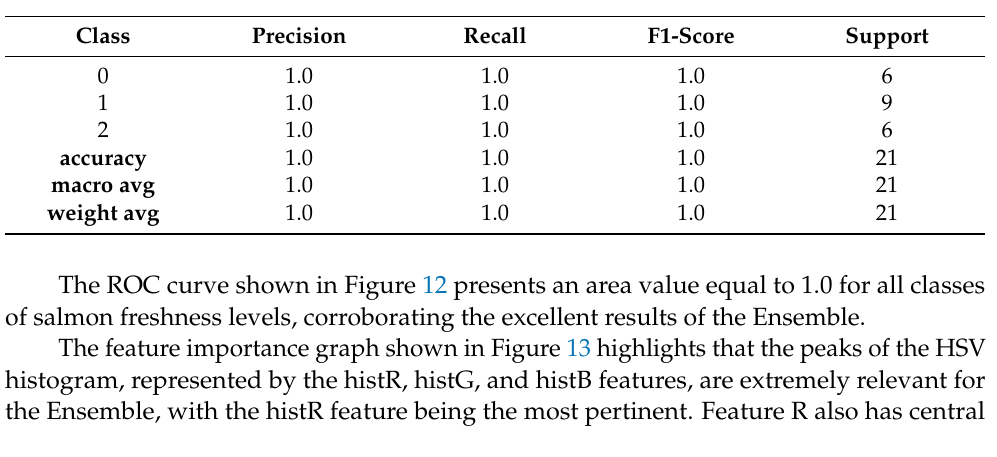
Table 3. Ensemble model metrics for sorting salmon samples.